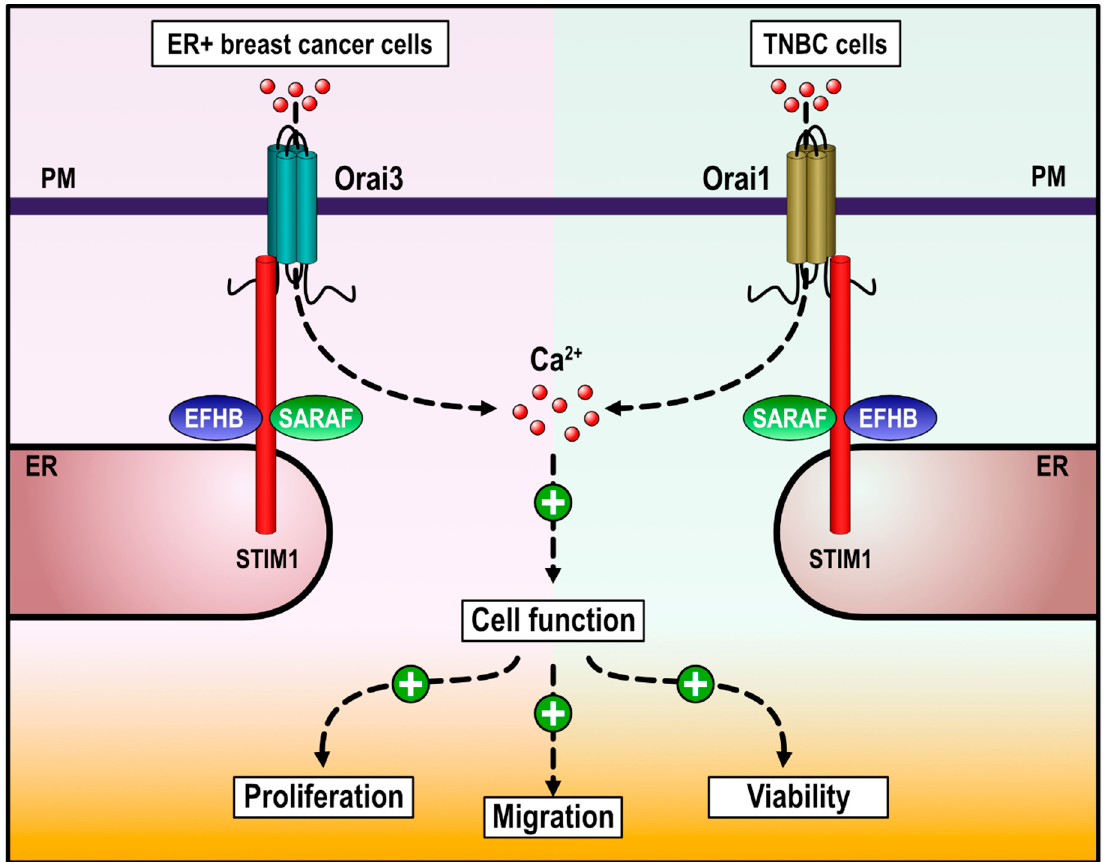
Figure 6. Cartoon summarizing the functional role of SARAF and EFHB in ER+ and triple negative breast cancer (TNBC) cells. In ER+ breast cancer cells and TNBC cells, SOCE is predominantly mediated by Orai3 and Orai1 channels, respectively. SARAF and EFHB modulate STIM1 activation and function and fine-tune SOCE, resulting in adequate Ca 2+ signals for cell proliferation, migration, and viability.